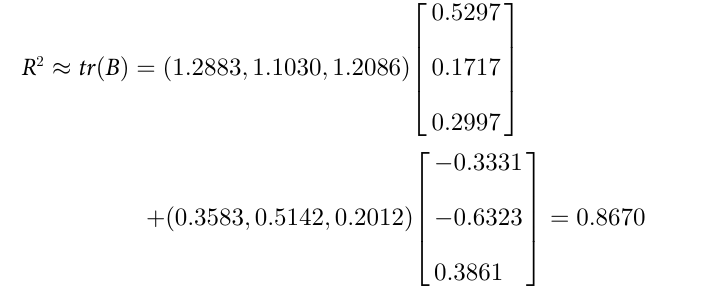
Table 4. t test statistics value of R �